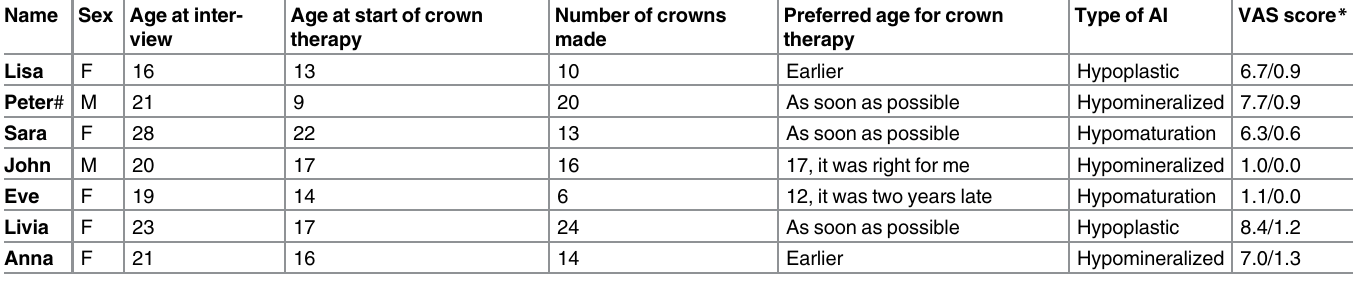
Table 1. Clinical data of interviewed